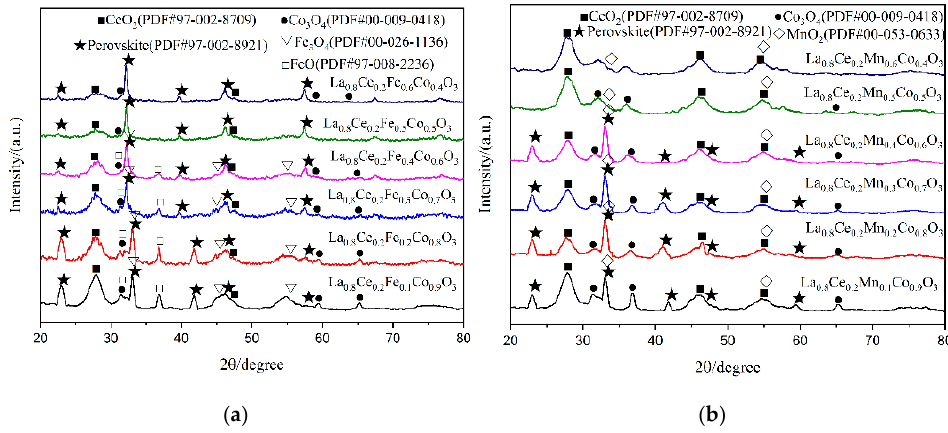
Figure 11. XRD patterns of catalyst samples: ( a ) La 0.8 Ce 0.2 Co 1-y Fe y O 3 catalyst samples; and ( b ) La 0.8 Ce 0.2 Co 1-y Mn y O 3 catalyst samples.